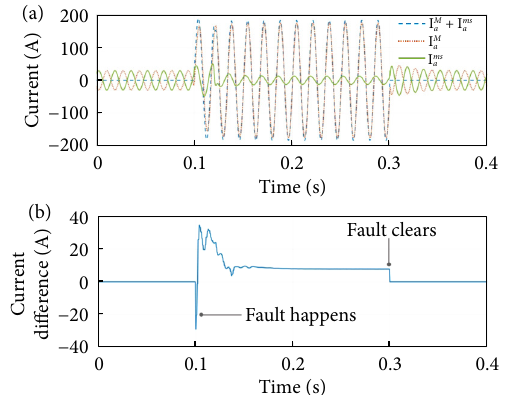
Fig. 6 Results for single-phase-to-ground faults with learning-based AFM. ( a ) phase currents at the fault location. are total fault currents to the ground, fault currents from the main grid, and fault currents from microgrids, respectively. ( b ) The magnitude difference between and , i.e.,